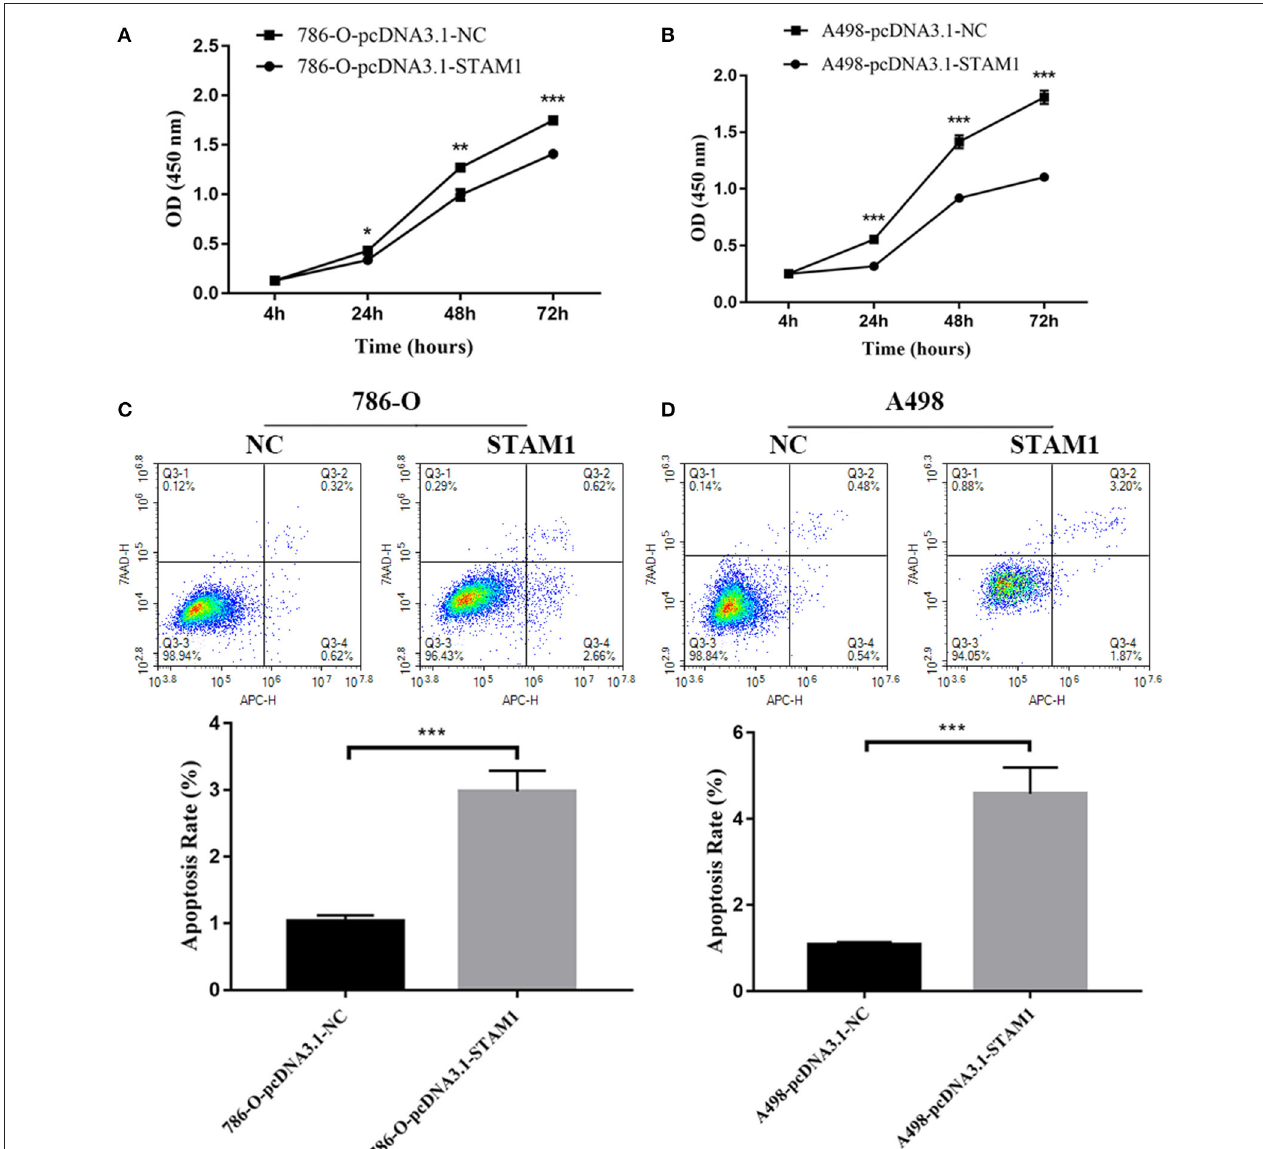
FIGURE 6 | Cell viability and apoptosis assessment after overexpressing STAM1 in 786-O and A498 cells. The cell viability of 786-O (A) and A498 (B) cells was examined by the cell counting kit-8 assay. The apoptosis rates of 786-O (C) and A498 (D) cells were evaluated by Annexin V-APC/7-AAD double-staining method and flow cytometry. * p < 0.05, ** p < 0.01, and *** p <